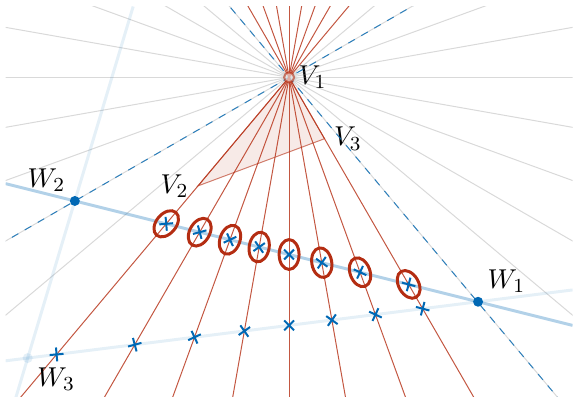
Figure 7 . The S 1 residue contour is well-defined when the fibre transversally intersects the hyperplane under study ( H by H on the fibre moves towards that by H 2 Similar phenomenon occurs for W